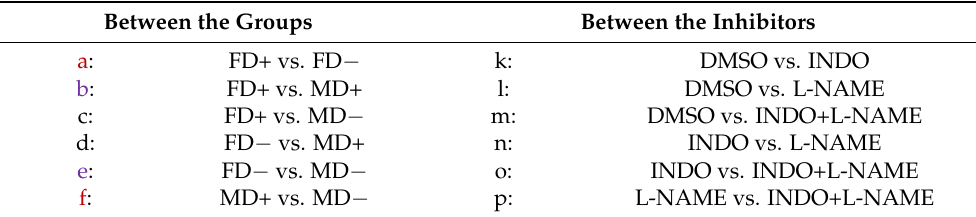
Table 1. The number of the symbols (x) indicates the strength of the significance: x: p < 0.05, xx: p < 0.01; xxx: p < 0.001. The meanings of the letter colors are as follows: gender difference is indicated by violet ( b , e ), while burgundy highlights a significant difference through different vitamin D statuses ( a , f